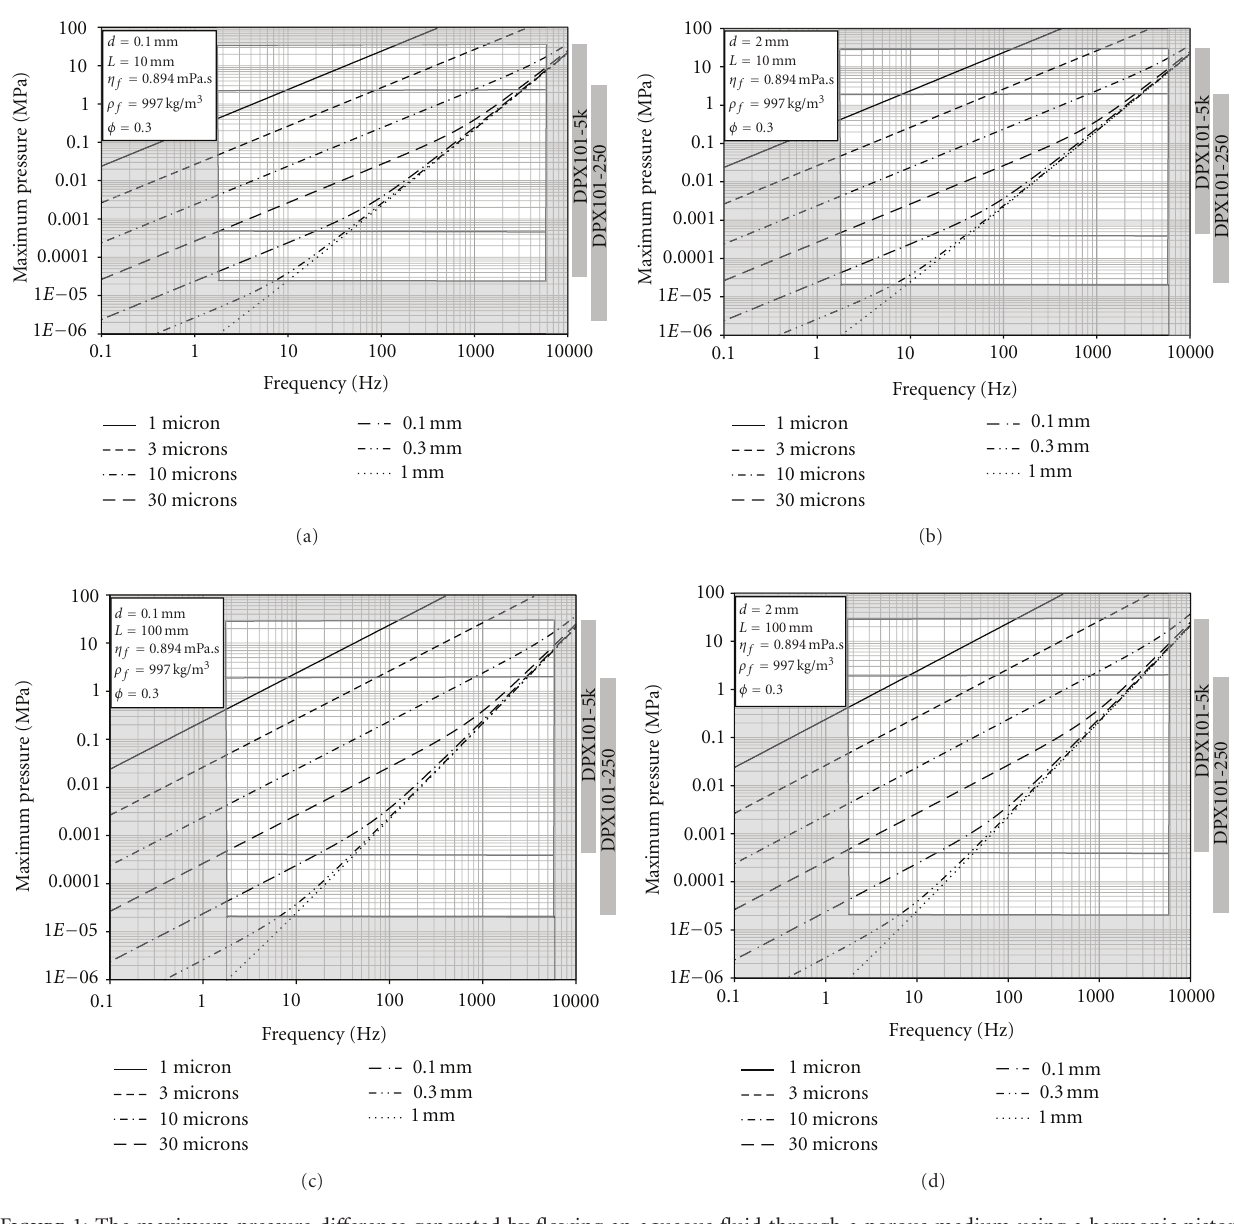
Figure 1: The maximum pressure di ff erence generated by flowing an aqueous fluid through a porous medium using a harmonic piston. Imposed piston frequency (from 0.1 to 10 4 Hz), φ = 0 . 3, sample length L (10 and 100 mm) and piston displacement d (0.1mm and 2mm), with the fluid parameters η f = 8 . 96 × 10 − 4 Pa . s and ρ f = 997 kg / m 3 , which correspond to a 10 − 3 mol/L solution of NaCl at 25 ◦